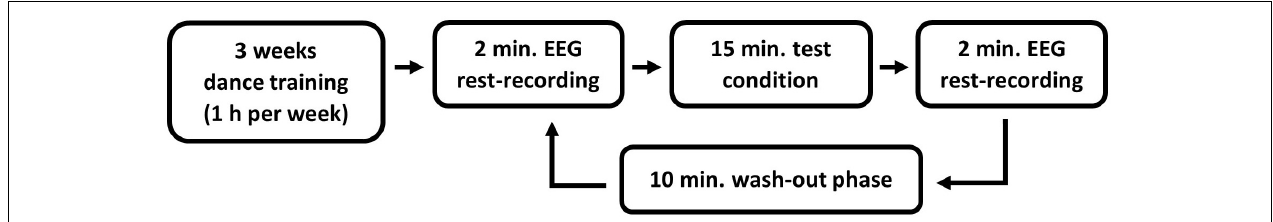
FIGURE 1 | Overview of the experimental